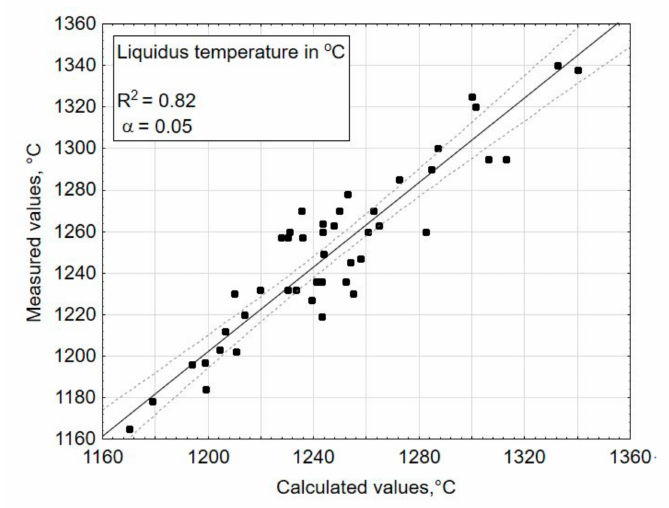
Figure 6. Comparison of the measured values (experimentally tested) and the estimated values (calculated using the chosen mathematical model)—for a dependent variable: liquidus temperature in ◦ C.